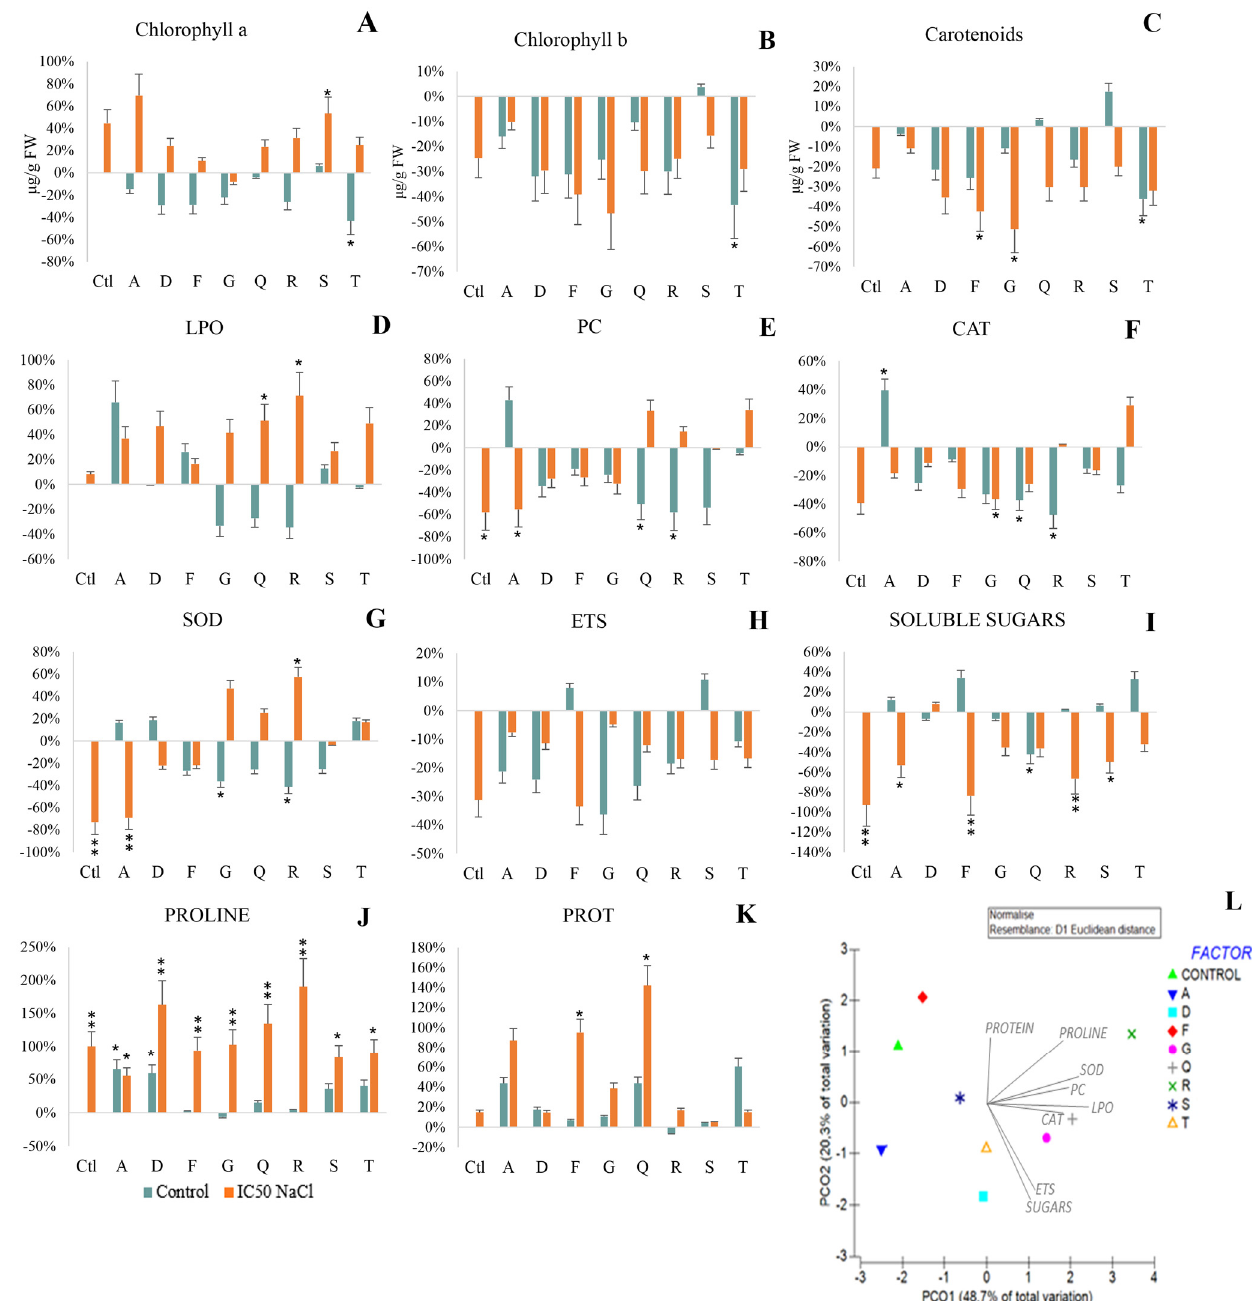
Figure 5. Maize plants grown for 7 days in non-saline and saline (1% NaCl-IC 50 ) conditions. Variation of photosynthetic pigments and biochemical parameters relatively to control (non-inoculated and non-salt exposed plants): ( A ) chlorophyll a; ( B ) chlorophyll b; ( C ) carotenoids; ( D ) Lipid peroxidation; ( E ) Protein carbonylation; ( F ) Catalase; ( G ) Superoxide Dismutase; ( H ) Electron transport system; ( I ) Soluble sugars; ( J ) Proline and ( K ) Protein. ( L ) Principal coordinates ordination of biochemical parameters variation of salt-stressed relatively non-salt exposed plants. Non-stressed (greenish bars) and salt-stressed (orange bars) plants were inoculated with different strains: Pantoea sp. (A); Pseudomonas sp. (D); Acinetobacter sp. (F); Stenotrophomonas sp. (G); Pseudomonas sp. (Q); Rhizobium sp. (R); Stenotrophomonas sp. (S); Pseudomonas sp. (T). Values are means of three replicates. Significant differences compared to control (non-inoculated and non-salt exposed plants) were marked with single asterisks ( p < 0.05) or double asterisks ( p < 0.01). For means, standard deviation and statistical significance see Supplementary Tables S4 and S5.